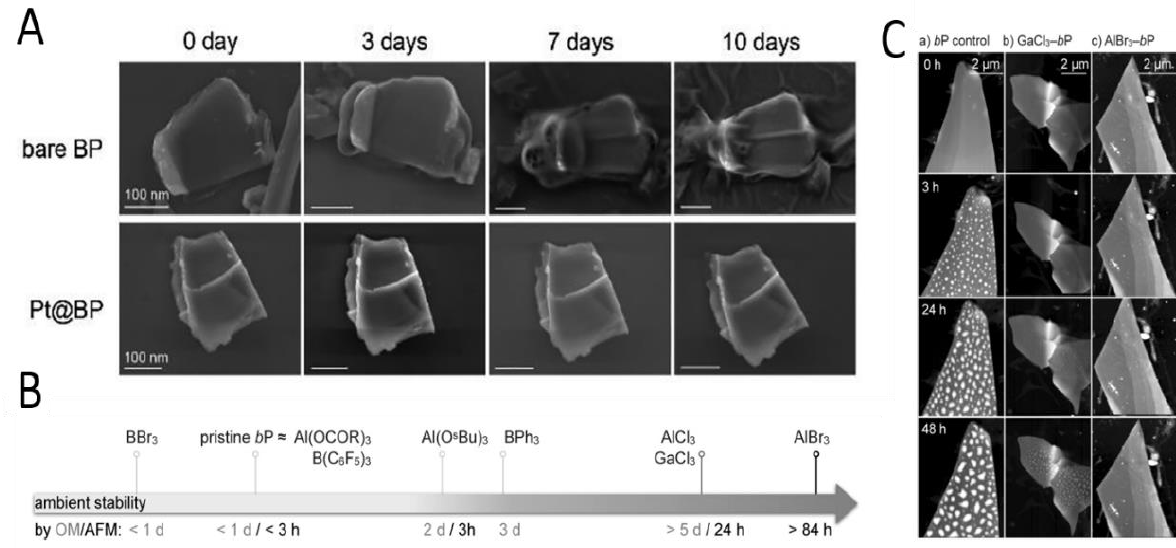
Figure 5. SEM images of bare BP and Pt@BP exposed in water for ( A ). Reproduced with permission [78]. Copyright 2019, ACS Publications. ( B ) Commercial group 13 Lewis acids investigated for